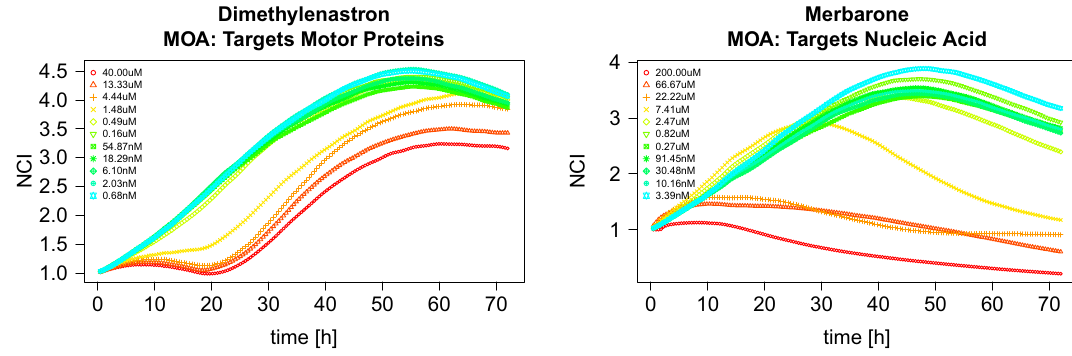
Figure 1. Examples of normalized data TCRCs from two chemicals with different MOAs and 11 concentration